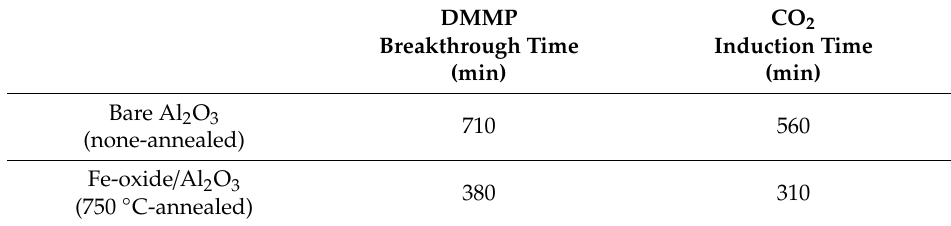
Table 2. DMMP breakthrough time and CO 2 induction time of bare Al 2 O 3 and Fe-oxide / Al 2 O 3 are